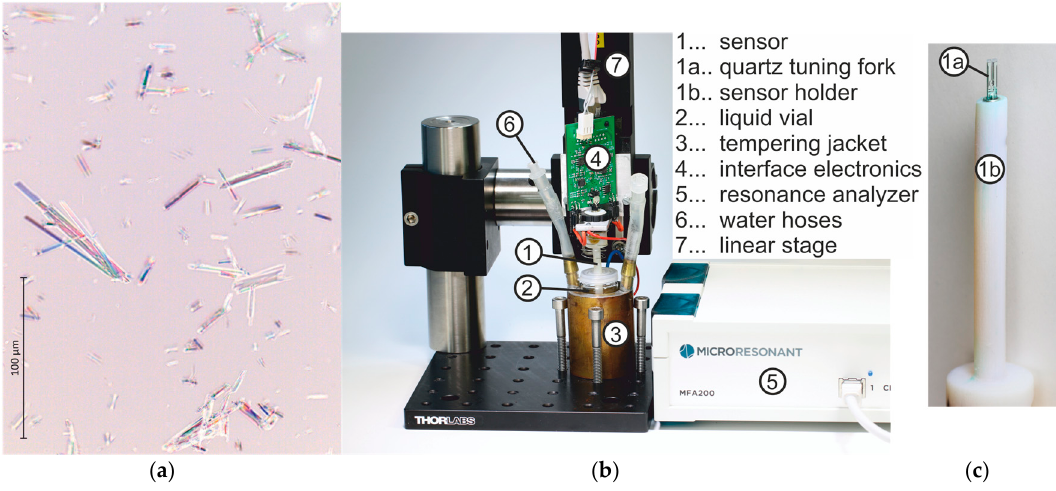
Figure 1. ( a ) Polarized light image of MSU crystals (growing procedure strictly following [7]); ( b ) Measurement setup and tuning fork sensor ( f r = 32.786 kHz in air); ( c ) The sensor is used to measure the temperature controlled liquid in the vial at multiple vertical positions using a linear